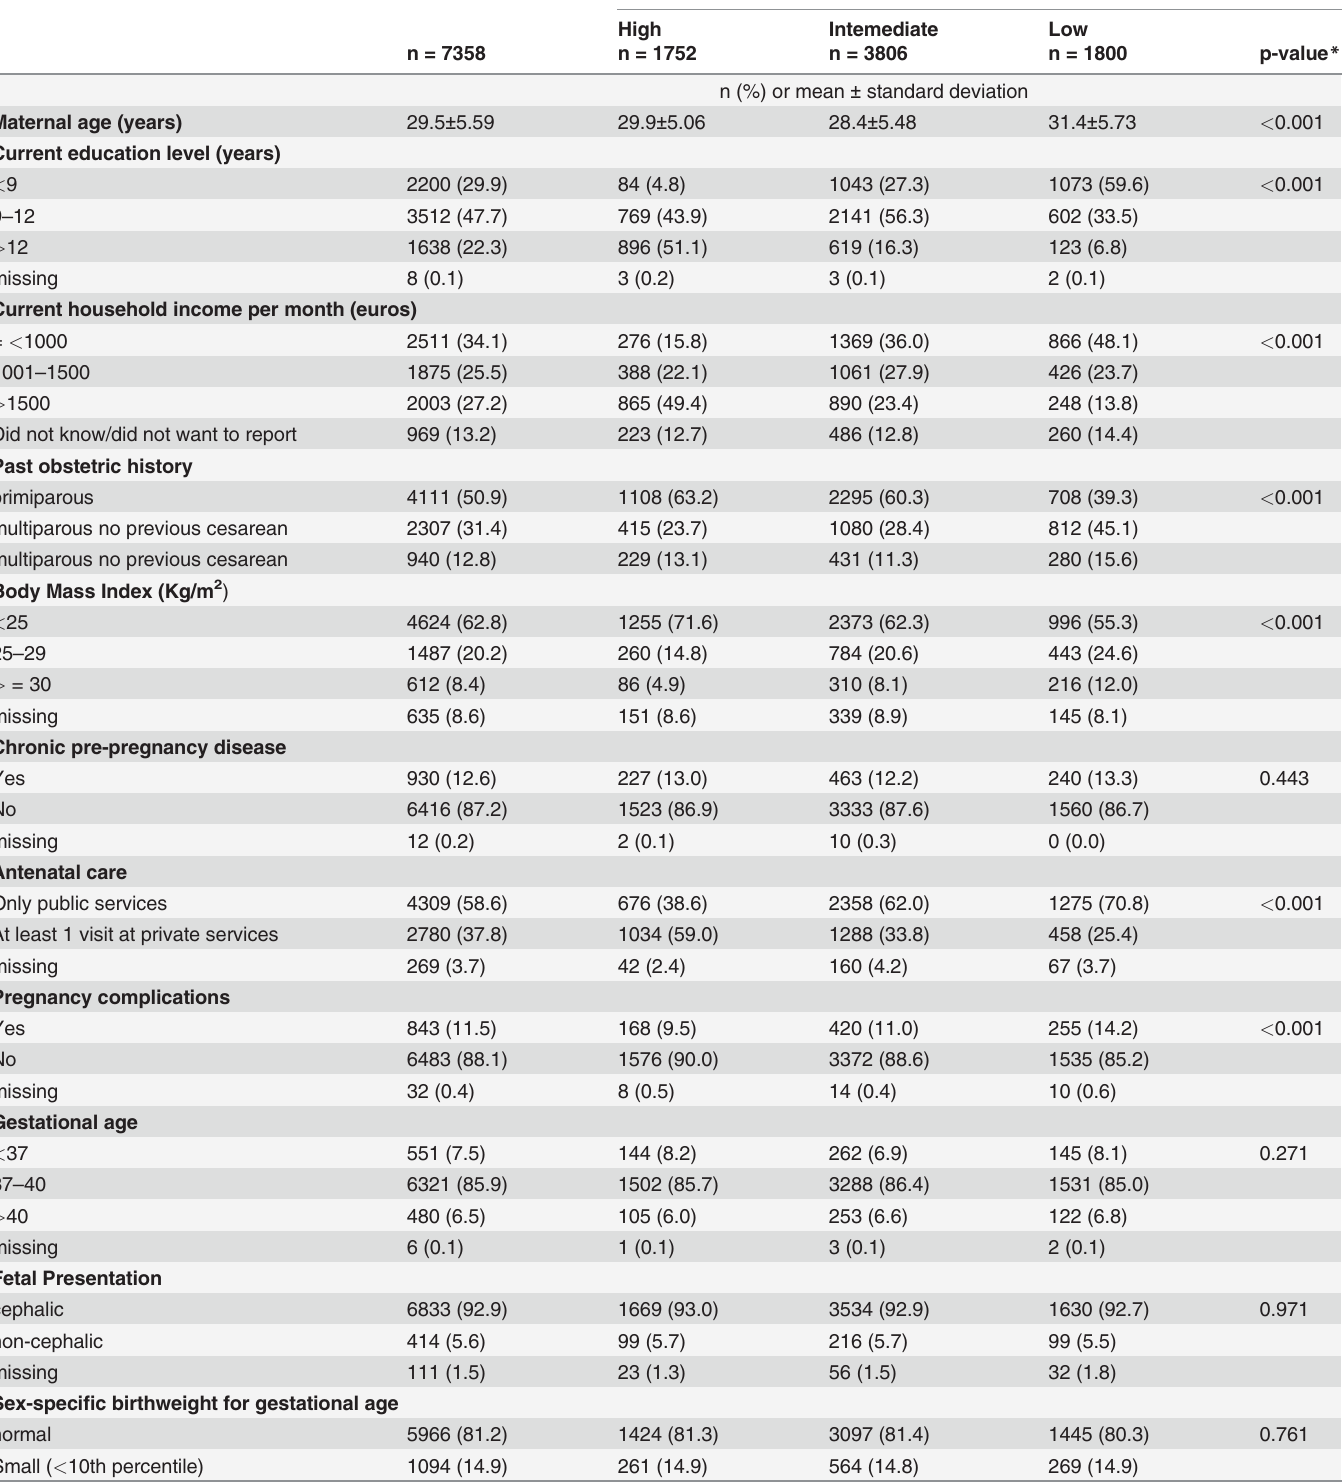
Table 3. Sample characteristics according to the